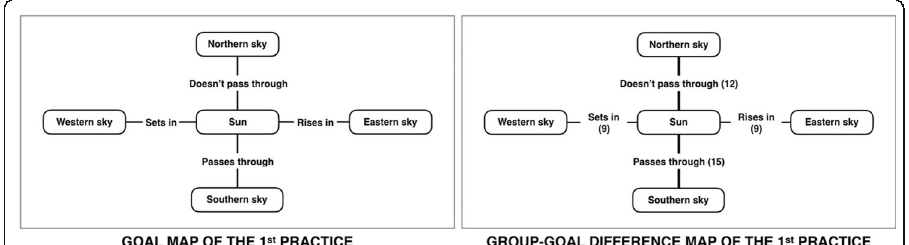
Fig. 7 The goal map and the group-goal difference map of the first practice